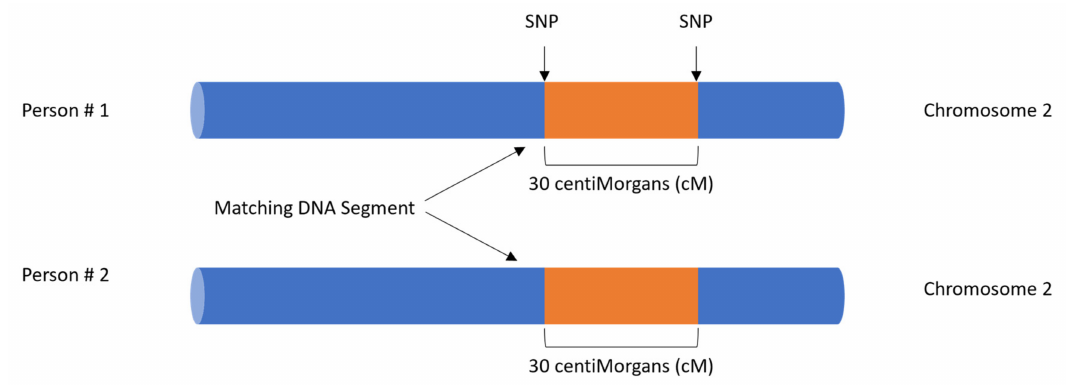
Figure 1. Matching DNA segment measured in centiMorgans (cM) for DNA